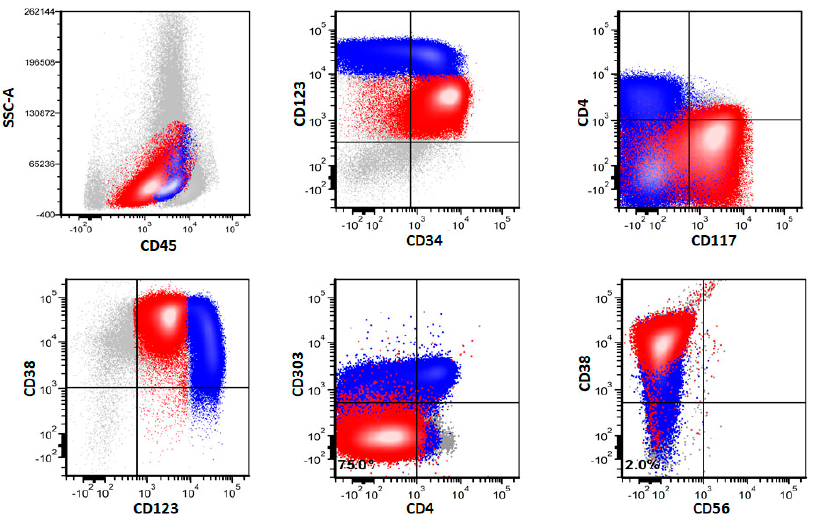
Figure 3. A representative case of pDC-AML by flow cytometry. Myeloblasts are highlighted in red and pDCs are highlighted in blue.